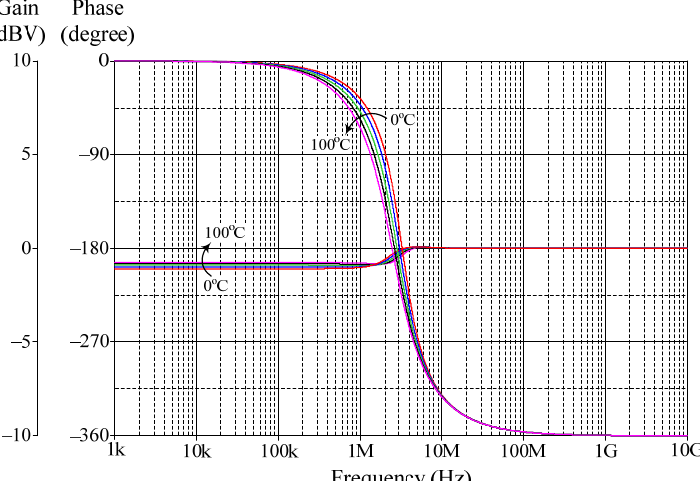
Figure 15. Frequency responses of AP filter in VM for different temperatures (0 °C, 25 °C, 50 °C, 75 °C, and 100 °C).